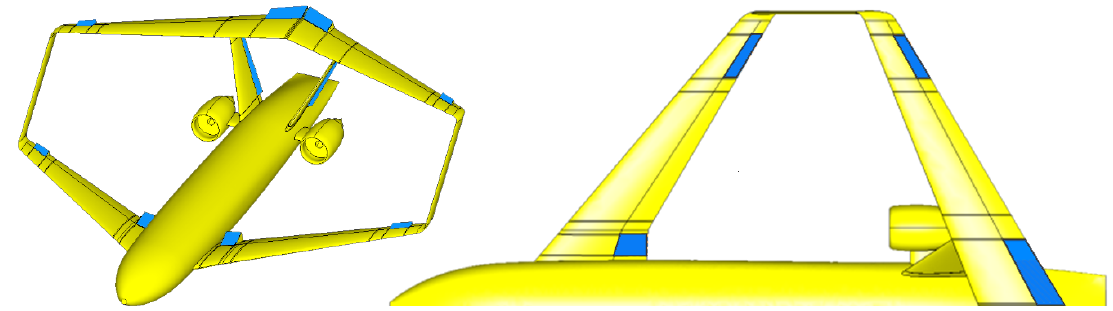
Figure 1. PrandtlPlane geometry and top view, with highlighted control